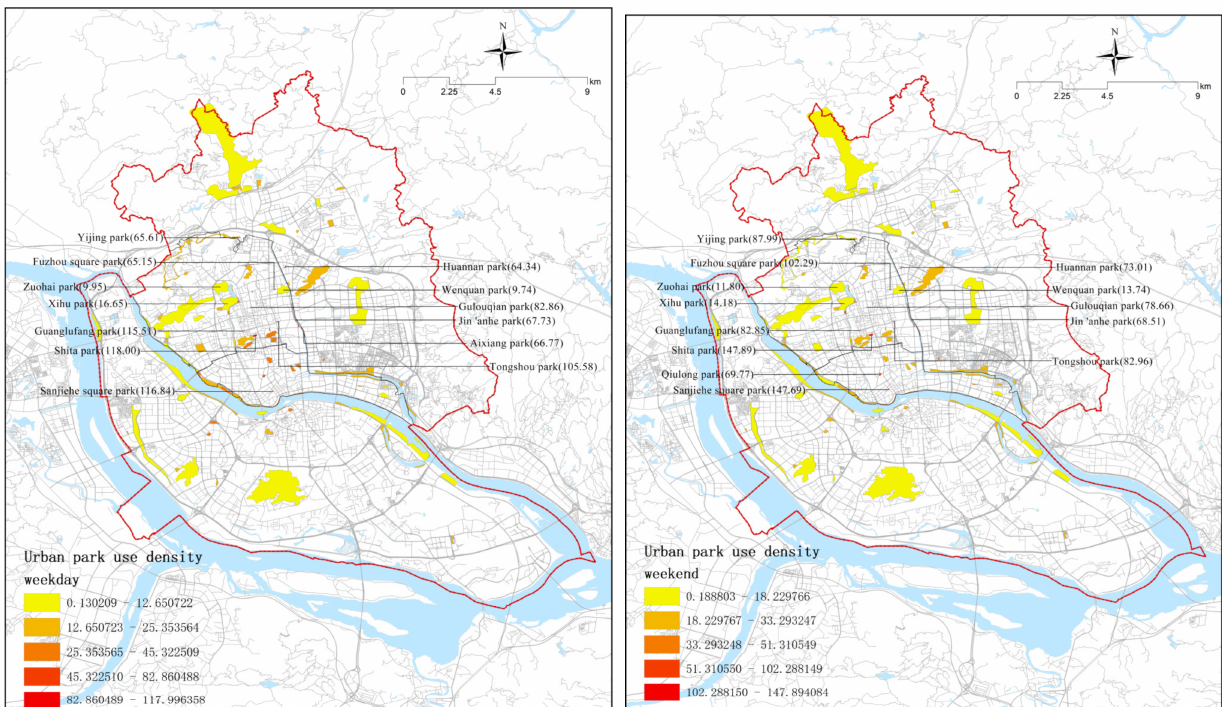
Figure 3. Spatial distribution of urban park use based on RTUD